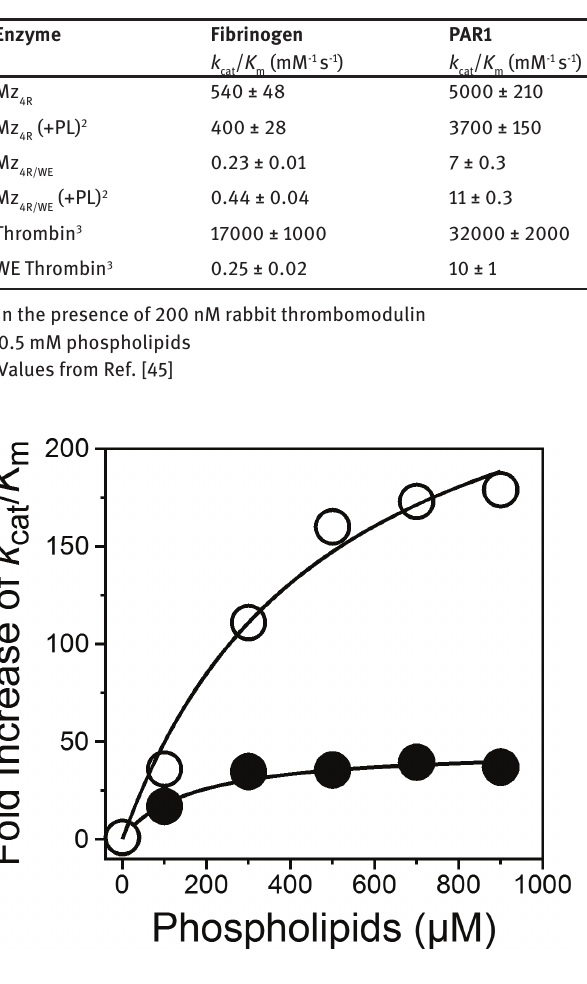
Figure 3 . Effect of phospholipids on the rates of protein C activation. The fold increase of the k / K value for activation of protein C cat m by Mz (closed circles) or Mz (open circles) relative to the 4R 4R/WE absence of phospholipids is plotted as a function of phospholipid concentrations. The fold increase at saturating concentrations of phospholipids is 47±4 for Mz and 290±60 for Mz , with 4R 4R/WE apparent K values of 0.16±0.05 mM and 0.5±0.2 mM, respectively. d Experimental conditions are: 145 mM NaCl, 5 mM CaCl , 0.1% 2 PEG8000, 20 mM Tris, pH 7.5 at 37